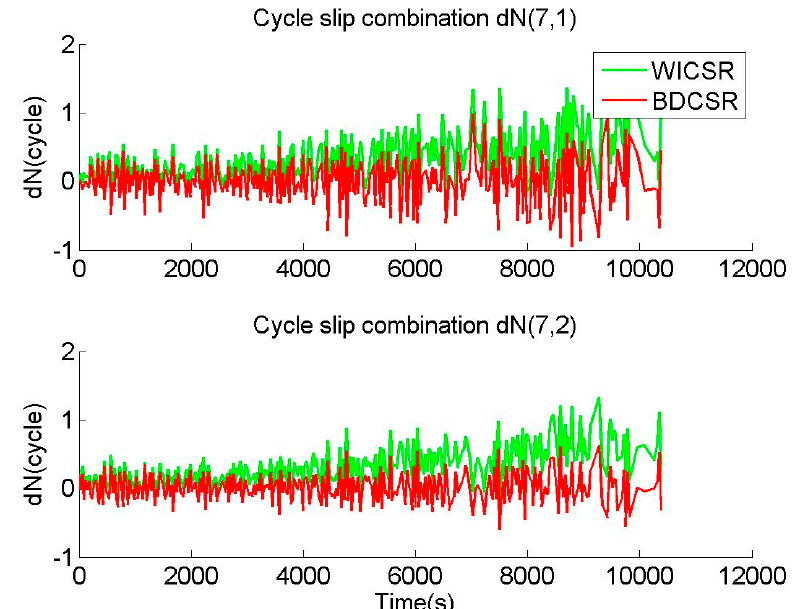
Figure 5. The cycle-slip combinations of WICSR without correcting the ionospheric variations and those of the BDCSR methodology after correcting the ionospheric variations, where the BDS dual- frequency pseudoranges and phases without cycle slip were collected from the MEO Satellite 11 during the geomagnetic storm, started from UTC 8 May 2016 00:00:00 with an interval of 30 s at the CUT0 station.